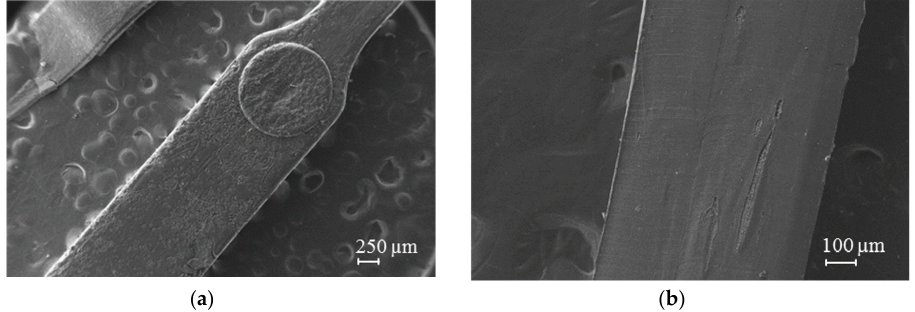
Figure 4. SEM micrographs taken at different magnifications of a PLA specimen molded at 24-300-1.2 condition. Table 1. Molding e ffi ciency and molecular weight of a polylactide (PLA) sample molded under several conditions a .